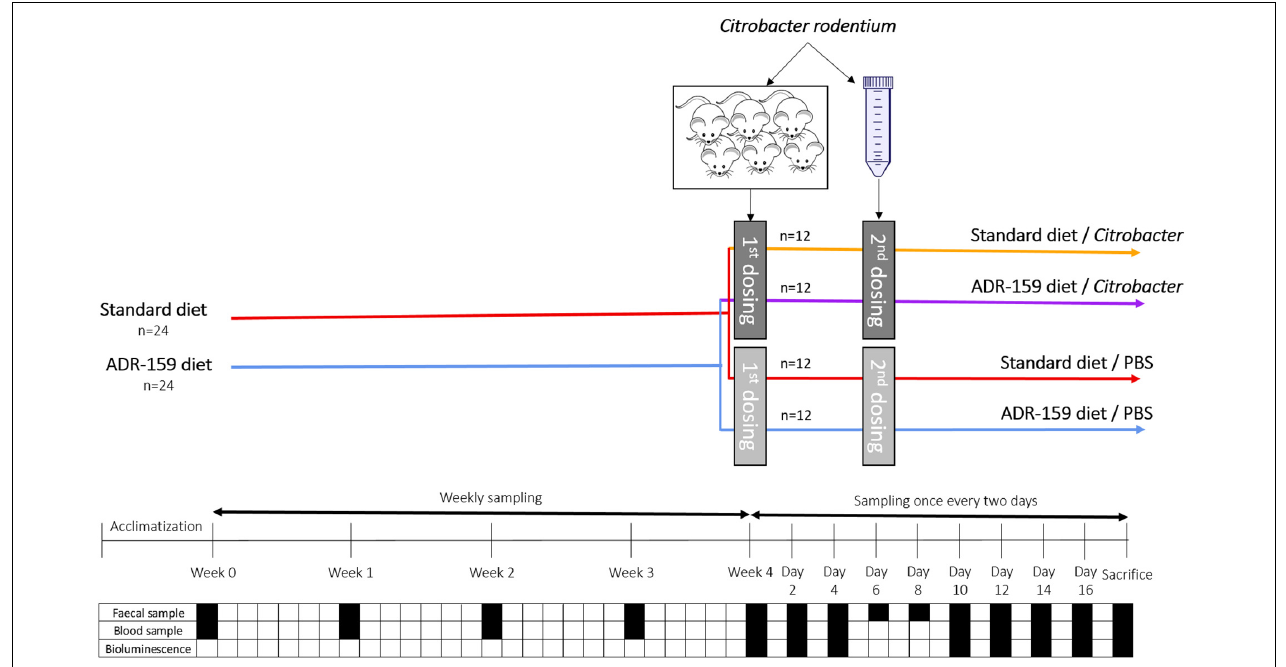
FIGURE 1 | Schematic representation of C . rodentium animal experiment. Dark gray indicates dosing containing Citobacter while light gray indicated dosing of animals with PBS. Black square indicates sampling, while white square indicates no sampling of given material type.